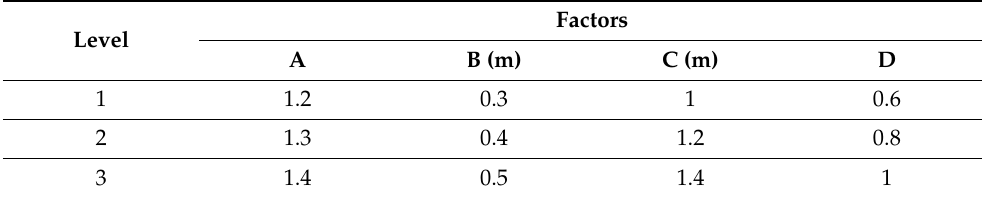
Table 1. Three levels with four